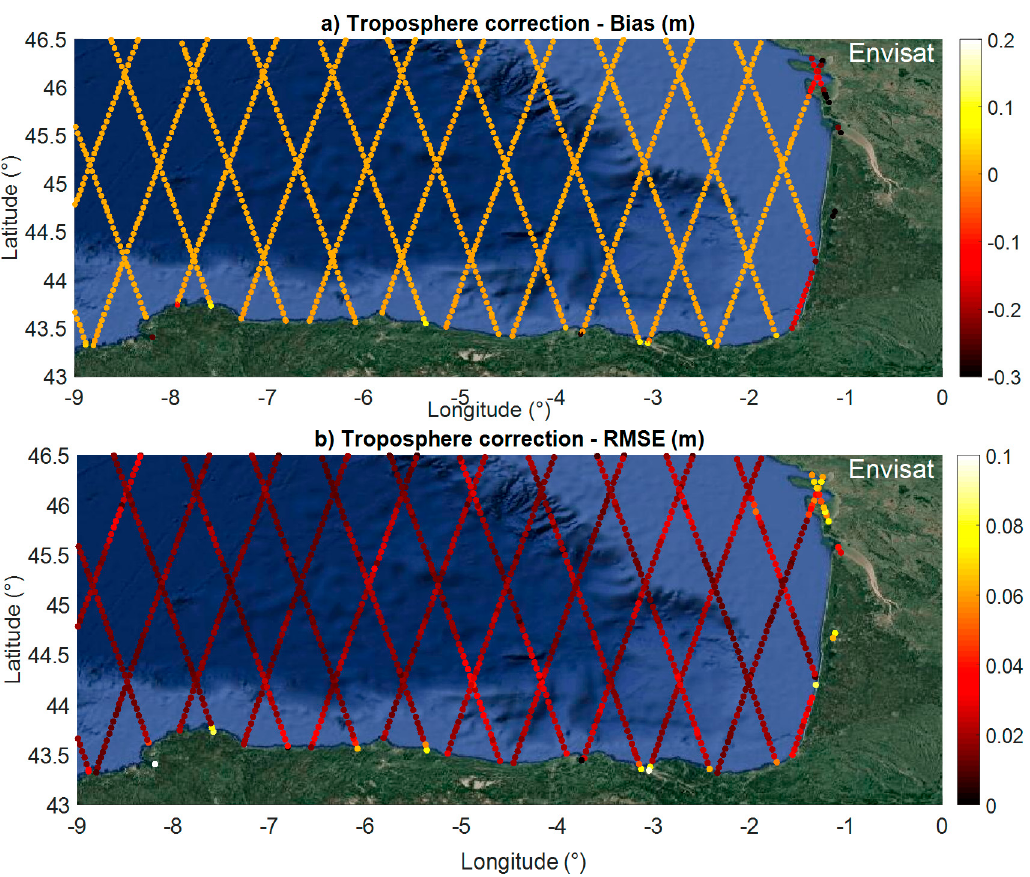
Figure 9. Comparison between wet troposphere corrections from radiometer measurements and the ECMWF model for Envisat: ( a ) bias and ( b ) RMSE. Remote Sens. 2018 , 10 , 93